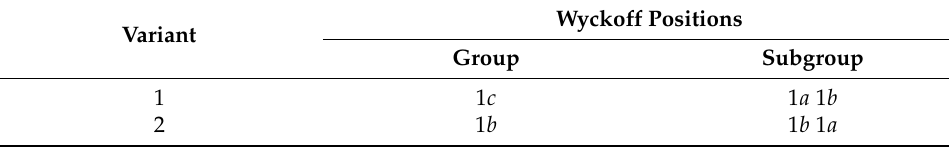
Table 3. Wyckoff position splitting schemes for the P 3 m 1 > P m